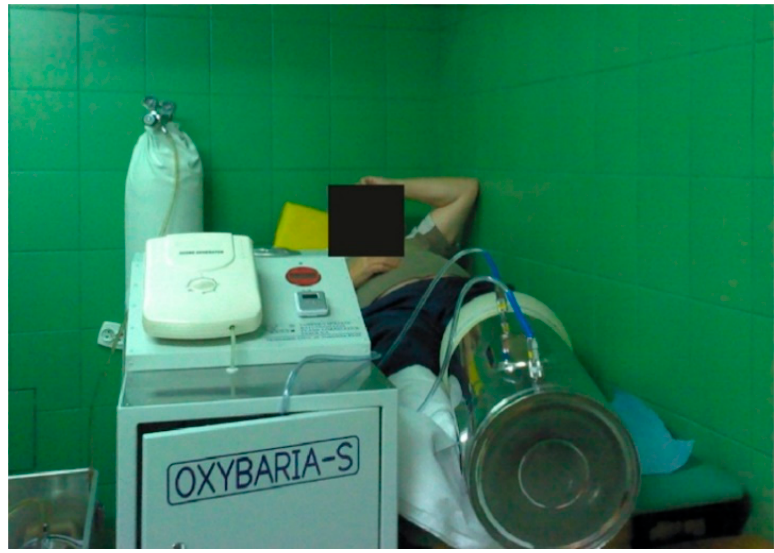
Figure 1. Topical hyperbaric chamber—the OXYBARIA—S apparatus (FASER, Tarnowskie Góry, Poland).